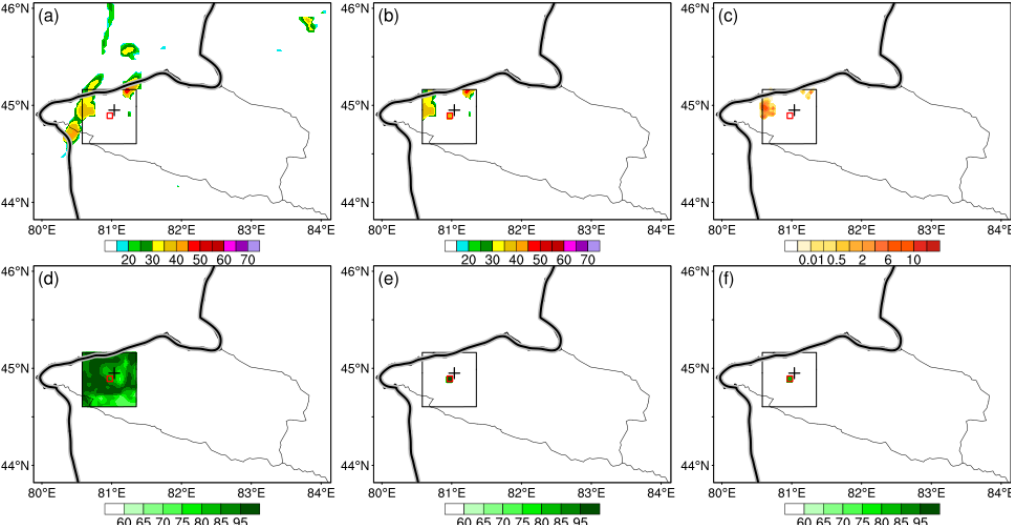
Figure 4. The single reflectivity (unit dBZ) observation test of the relative humidity (unit %) retrieved at 12th model level. ( a ) Assimilated reflectivity. ( b ) Observed reflectivity. ( c ) Weight of each assimilated reflectivity. ( d ) Assimilated relative humidity. ( e ) Relative humidity retrieved using the updated scheme. ( f ) Relative humidity retrieved using the original scheme. The black square indicates the window of 21 × 21 grid points used for the Bayesian method. The red square indicates the single reflectivity observation